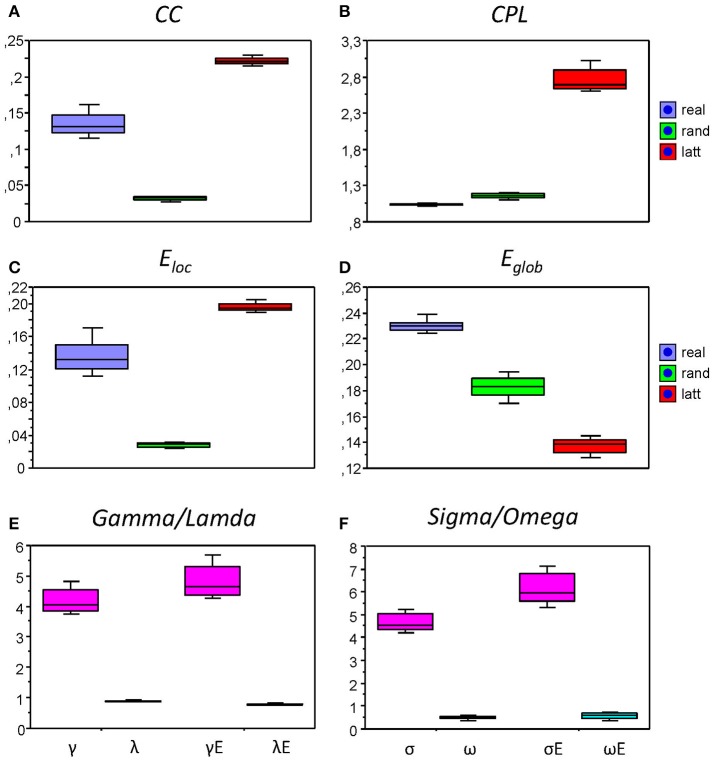
Box plots of the mean of the small-world metric for the real and control networks (random and regular/lattice). (A) Clustering Coefficient (CC); (B) Characteristic Path Length (CPL); (C) Local efficiency (Eloc); (D) Global efficiency (Eglob); (E) Normalized Clustering Coefficient (γ = CCreal/CCrand) and Characteristic Path Length (λ = CPLreal/CPLrand) as well as normalized Local Efficiency (γE = Eloc(real)/Eloc(rand)) and Global Efficiency (λE = Eglob(real)/Eglob(rand)); (F) Small-world coefficients: σ, ω, σE, and ωE.